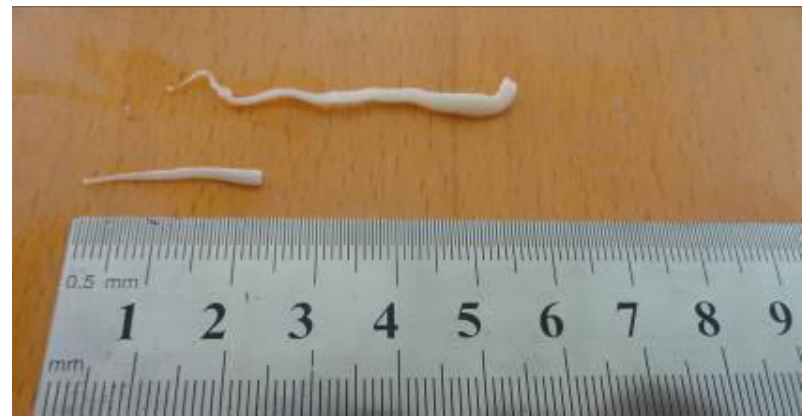
Figure, 4: Cotugina worm in